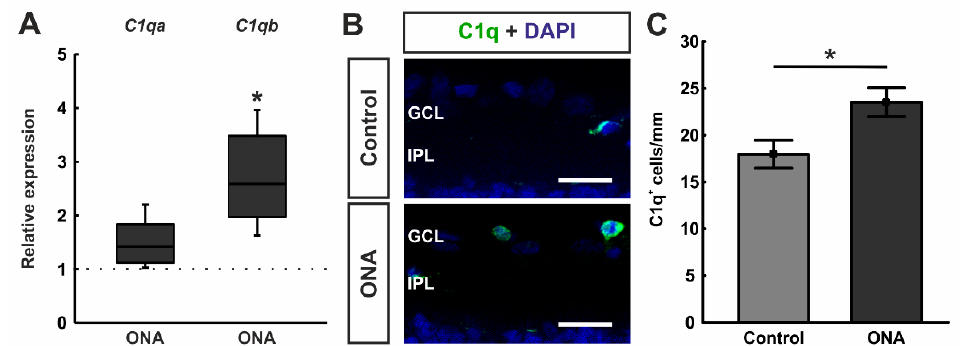
Figure 4. Enhancement of classical pathway components. ( A ) RT-qPCR analyses revealed a trend towards an upregulation in the mRNA expression levels of C1qa in ONA retinae ( p = 0.052), while a significant upregulation of C1qb mRNA expression levels was detected in ONA animals ( p = 0.037). ( B ) A C1q antibody was applied to retinal cross-section (green). DAPI counterstained cell nuclei (blue). ( C ) We noted significantly more C1q + cells in the GCL of ONA animals compared to controls ( p = 0.023). Scale bars: 20 µm. GCL = ganglion cell layer; IPL = inner plexiform layer. Values for RT-qPCR are median ± quartile ± minimum/maximum and values for immunofluorescence are mean ± SEM. The dotted line in ( A ) represents the relative expression of the control group. * p <